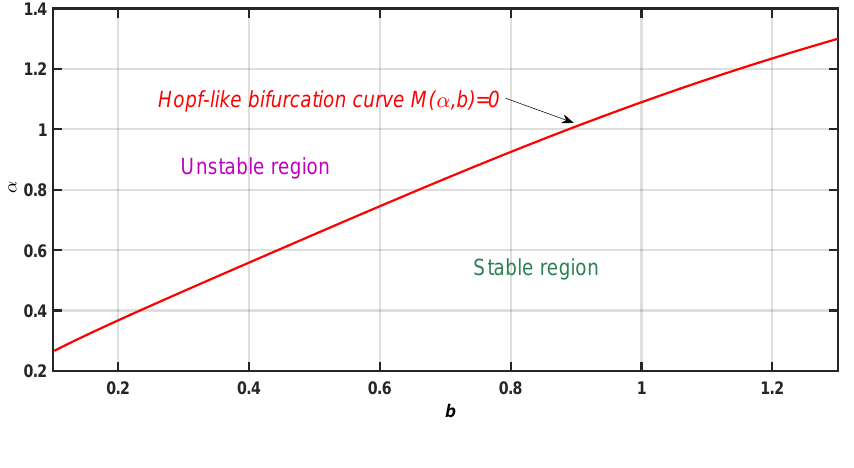
F IGURE 3 HLB curve in the ( b , α ) parameter space.